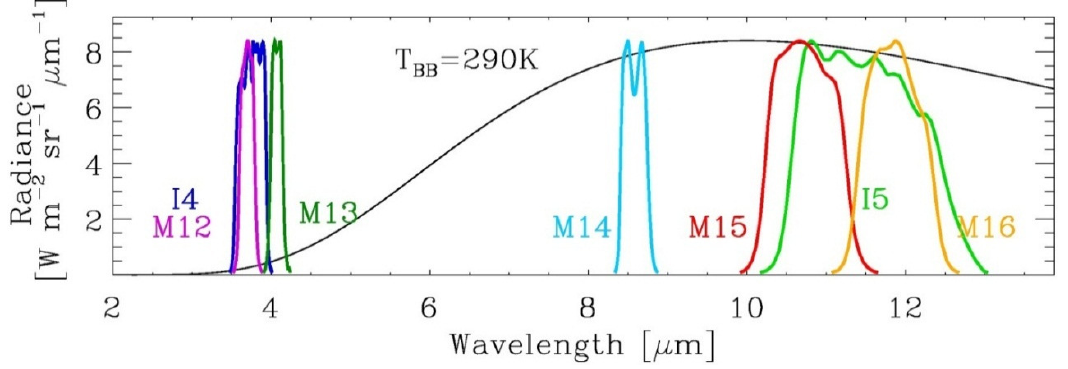
Figure 3. Relative Spectral Response of the VIIRS TEBs overlaid with spectral radiance of the BlackBody at 290 K [7]. Table 1. VIIRS and MODIS matching TEBs [7].